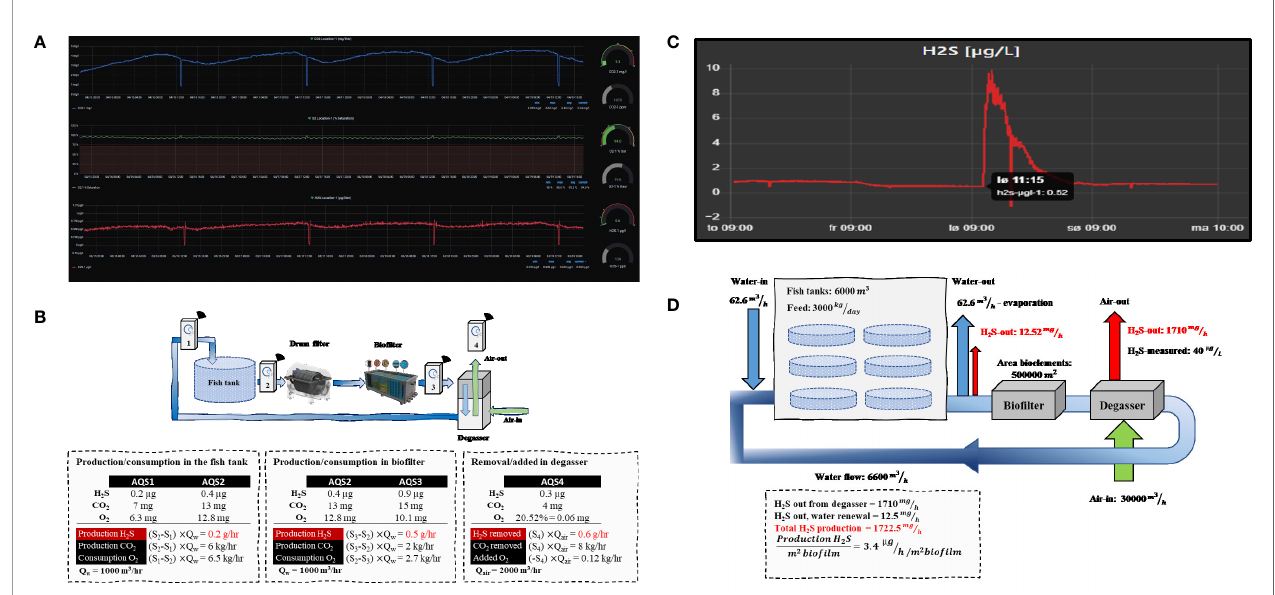
FIGURE 3 | (A) An example of AQS dashboard representing time-series for H 2 S (µg/L), CO 2 (mg/L), O2 (% saturation), pH, temperature ( ˚ C), and salinity ( ‰ ).The rapid spikes represent the calibration veri fi cation when the sensor was exposed to the calibrated source. (B) The overall calculation of mass balance changes in RAS. (C) The captured H 2 S sudden spike in the morning in the system, which was gradually removed through degassing process. (D) The calculation of H 2 S formation rate based on the area of bio fi lm per unit of